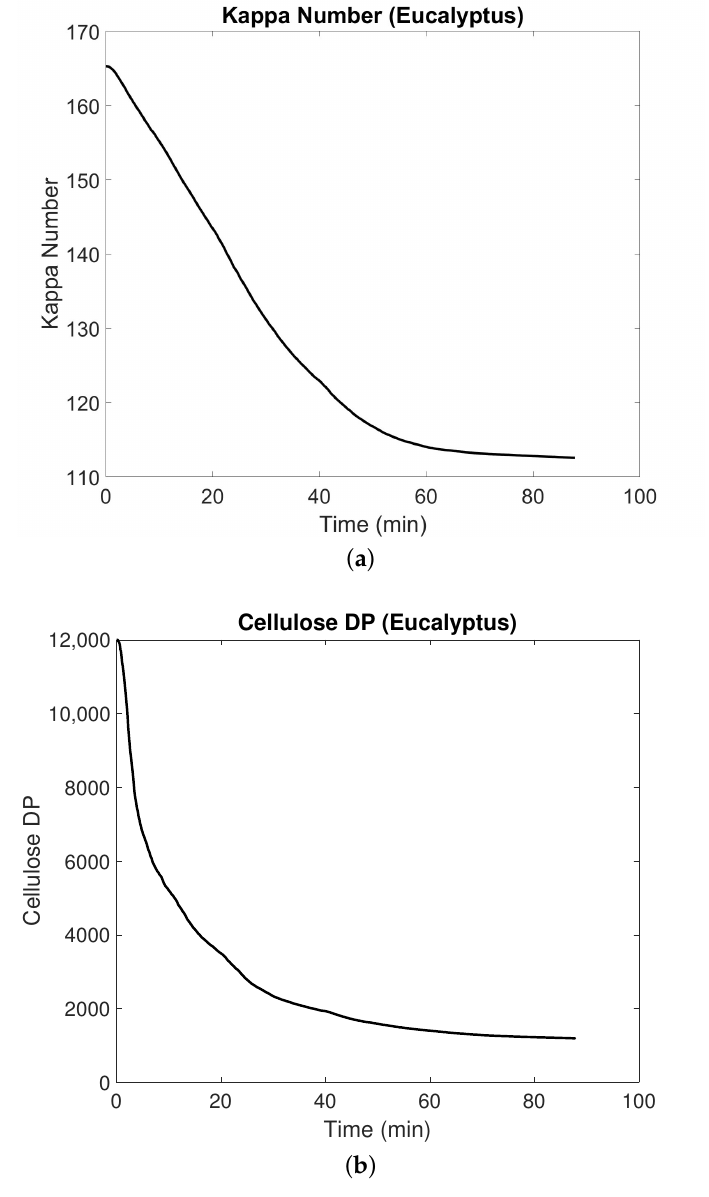
Figure 5. ( a ) The Kappa number predicted by the multiscale kMC model for Eucalyptus wood and ( b ) the degree of polymerization predicted by the multiscale kMC model for Eucalyptus